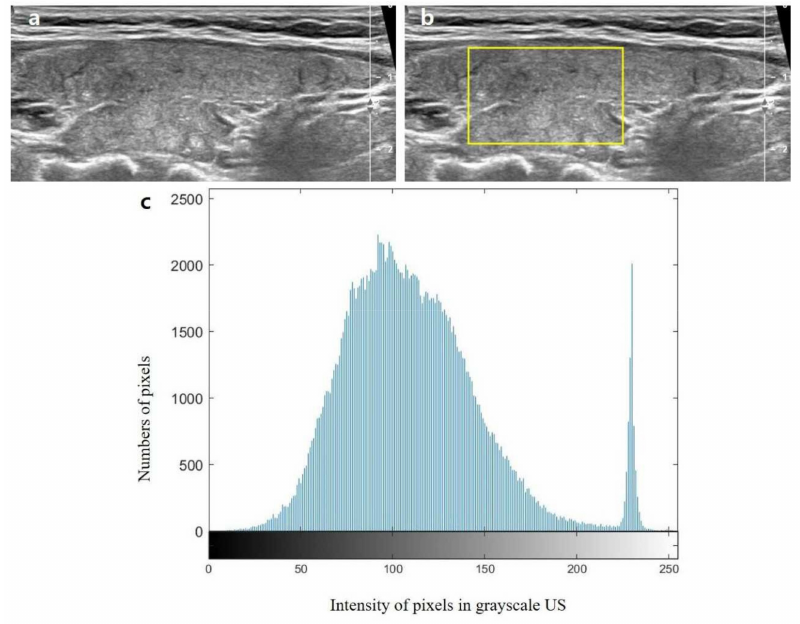
Figure 2. Example of texture analysis of gray-scale ultrasound (US) (on subject 18). ( a ) One longitudi- nal gray-scale US image was selected by an experienced radiologist. ( b ) The region of interest (ROI) was set to include a sufficient amount of thyroid parenchyma and was drawn by the radiologist. ( c ) From these ROIs, histogram parameters were automatically calculated with an in-house built software, which demonstrated the distribution of the number pixels (y-axis) according to the pixel intensity value (x-axis) within the